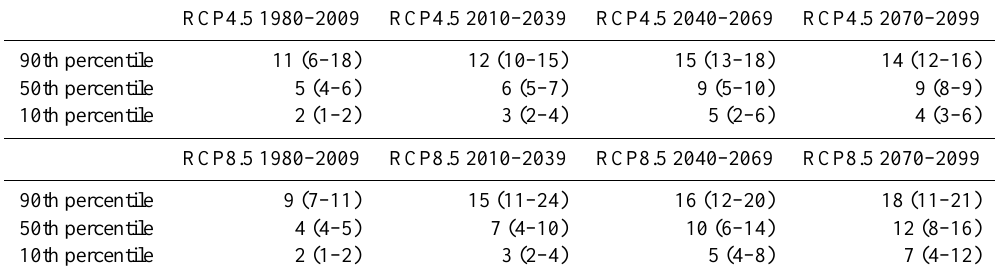
Table 5. The 90th, 50th, and 10th percentiles of multi-model mean annual number of large forest fires in Finland, excluding the Åland Islands. The range in the number of modelled large forest fires among the model projections is shown in parentheses.